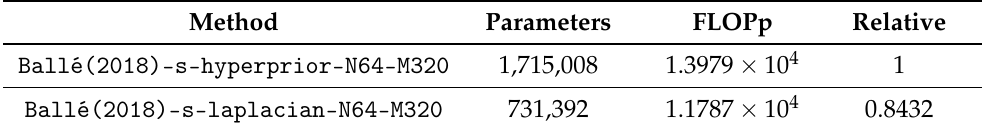
Table 5. Reduction of the encoder complexity induced by simplified entropy model on the coding part-Cas of rates above 2